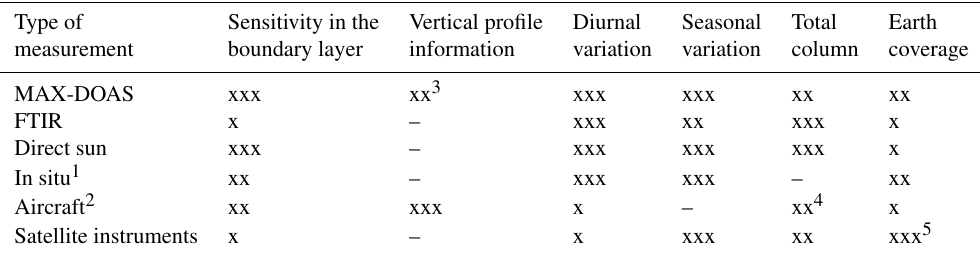
Table 12. Data and measurement types used for the validation of satellite HCHO columns. The information content of each type of measure- ment is qualitatively represented by the number of crosses. Type of Sensitivity in the Vertical profile Diurnal Seasonal Total Earth measurement boundary layer information variation variation column coverage